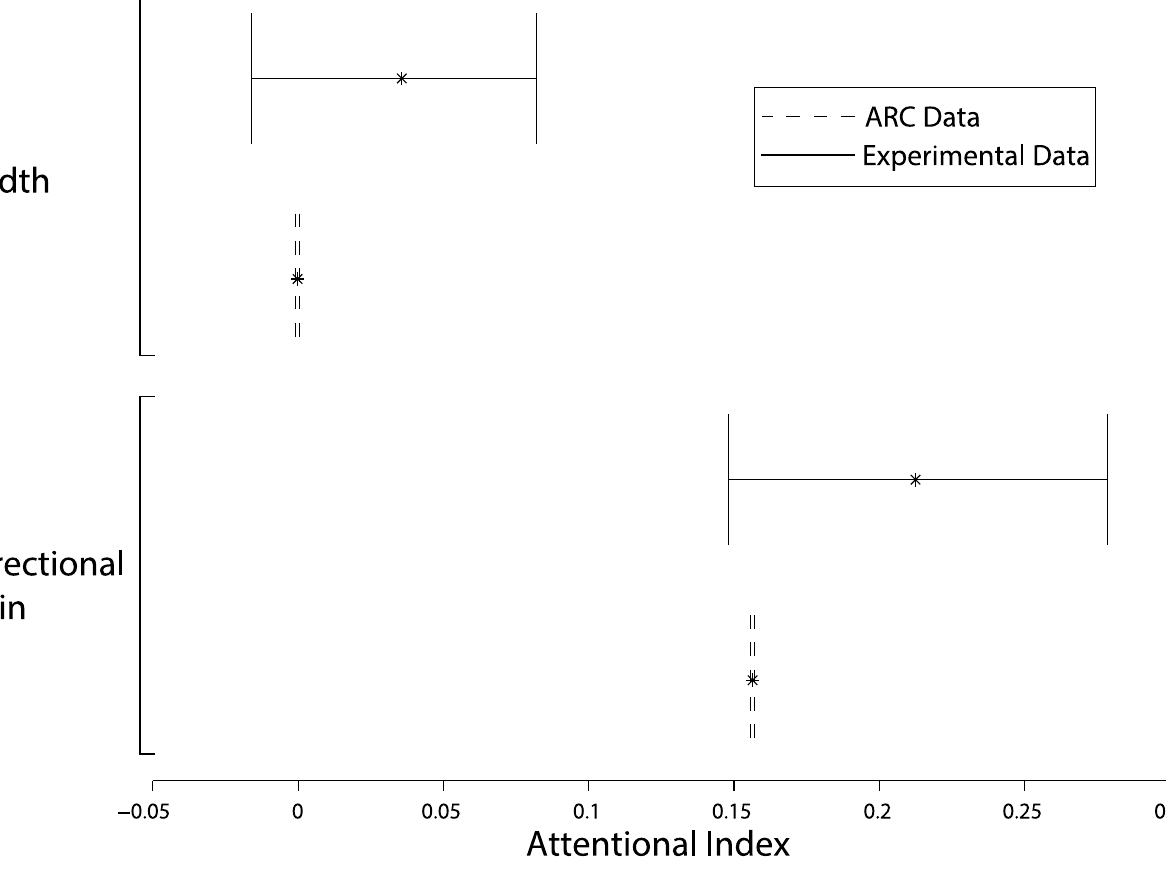
Figure 7. Summary of attentional effects on neural selectivity reported by [2] (solid lines) and from simulations using the ARC (dashed lines). The 95% confidence intervals of the simulation and experimental data overlap, with both showing a significant increase in gain, but no change in width.